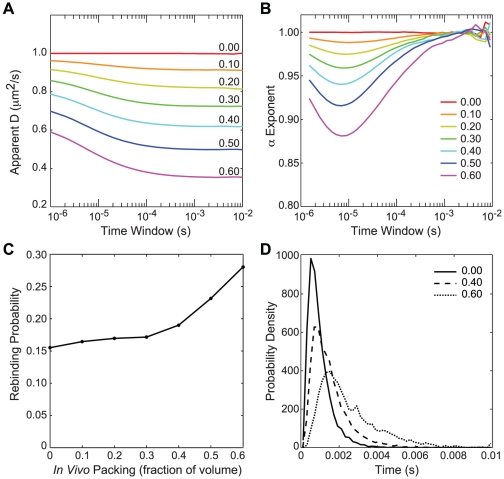
The effect of in vivo crowding on repressor rebinding.Each line represents the mean of 5000 trajectories. (A) The observed diffusion coefficient, , as a function of time scale for a repressor diffusing in a volume with the indicated fraction occupied by in vivo obstacles. (B) –exponent arising from fitting  to a model of anomalous diffusion, . (C) The probability for a repressor to rebind with the operator before diffusing into the bulk (64 nm from operator) following unbinding, as a function of the in vivo packing. (D) The distribution of escape times for repressors that diffuse to bulk rather than rebind, at three packing values.